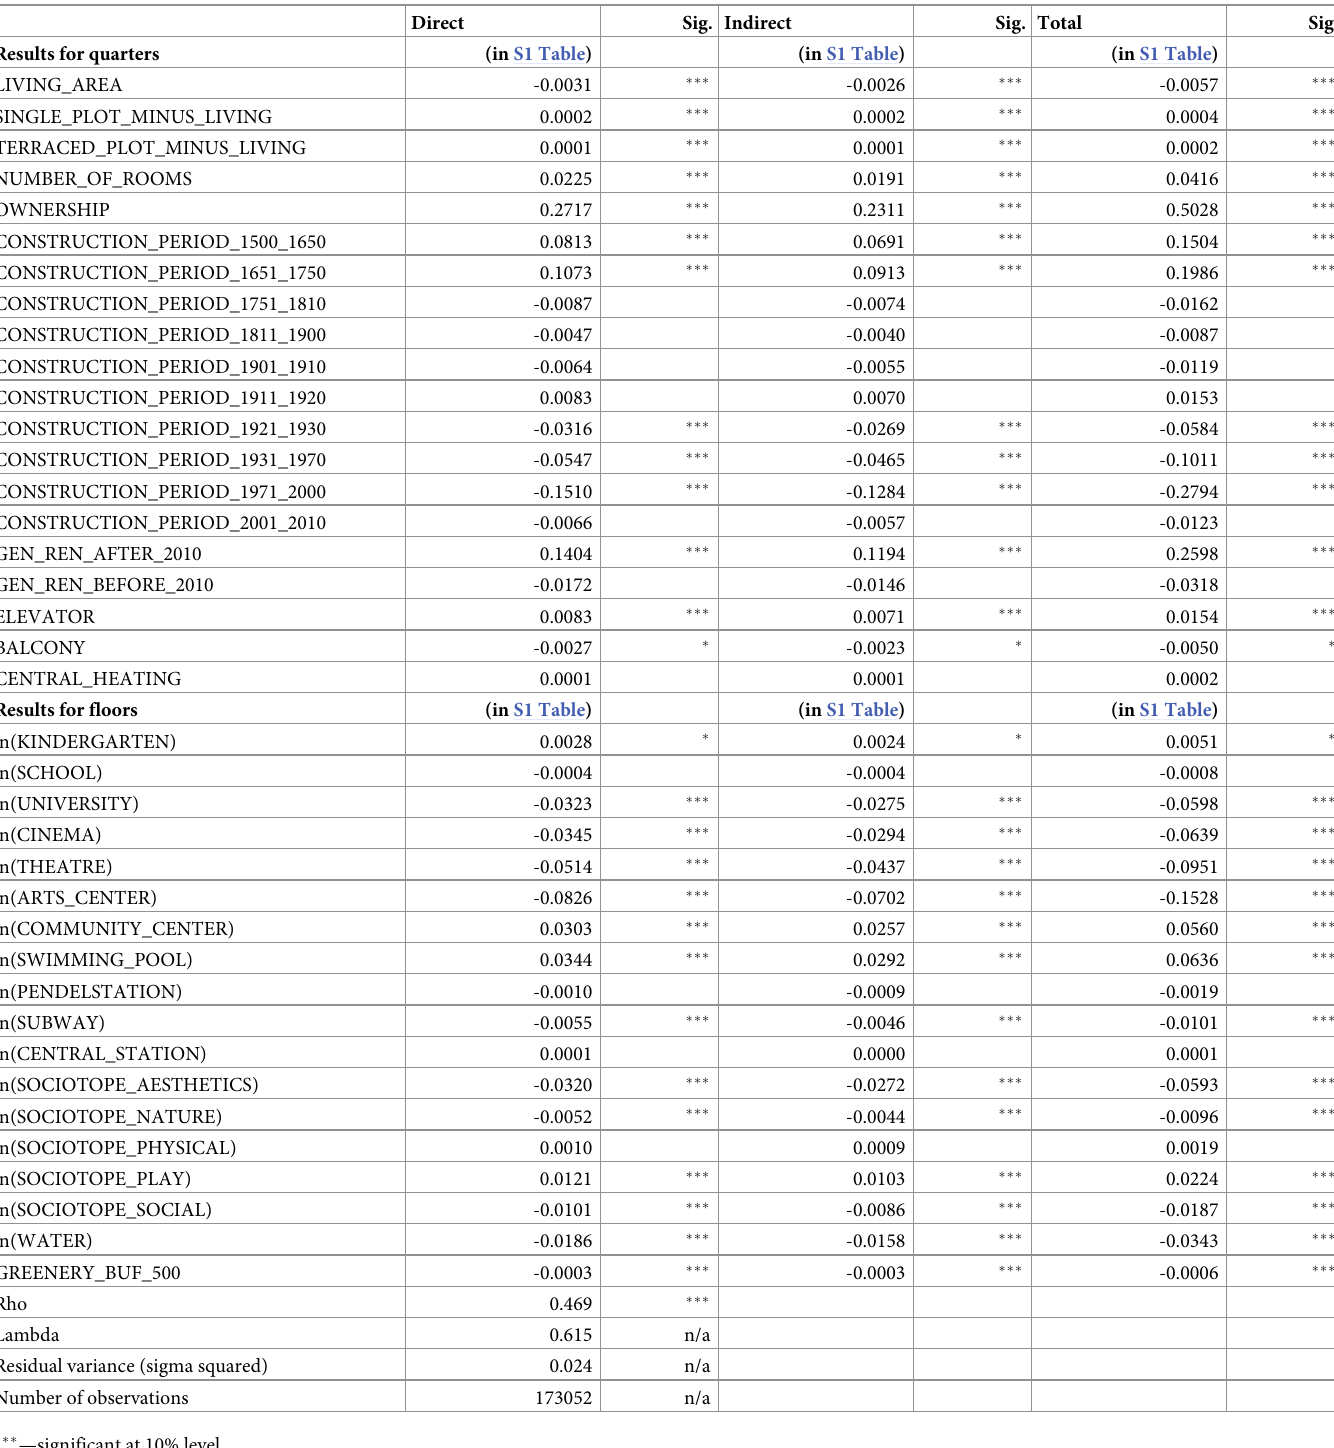
Table 3. Results of the first stage of the study (focused on the representativeness of green spaces to sociotope categories). Direct Sig. Indirect Sig. Total Sig. Results for